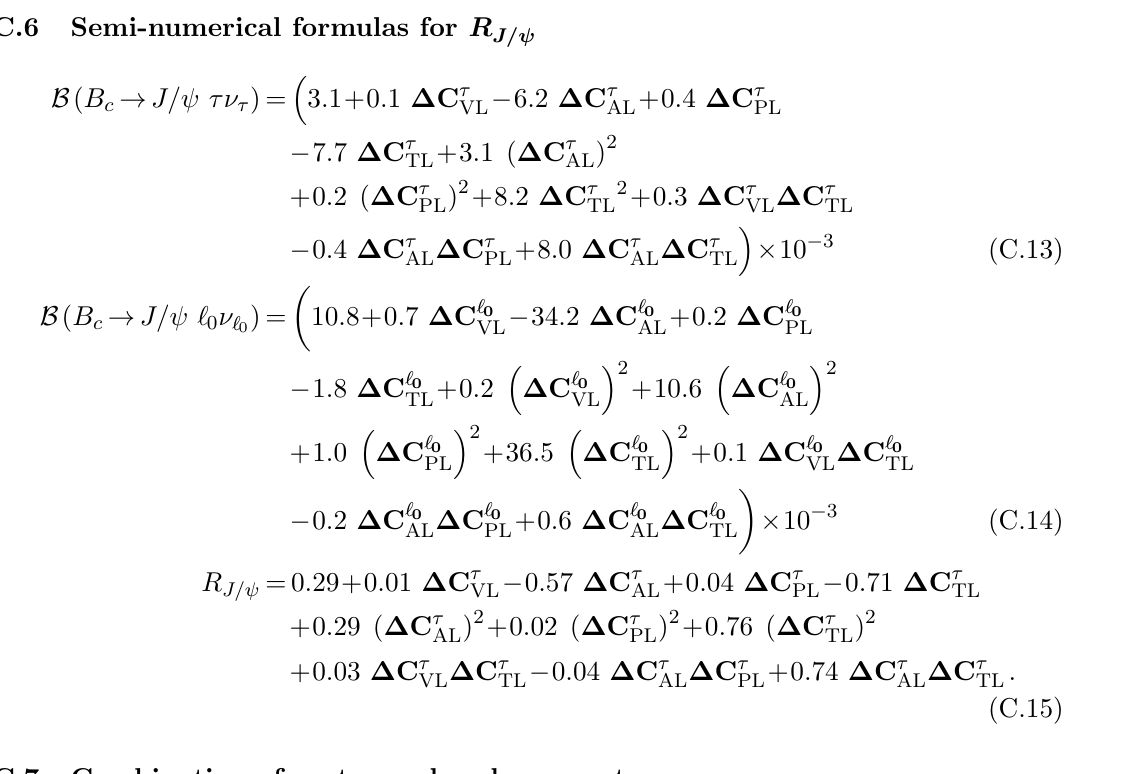
for the right panel) that satisfy the experimental PL